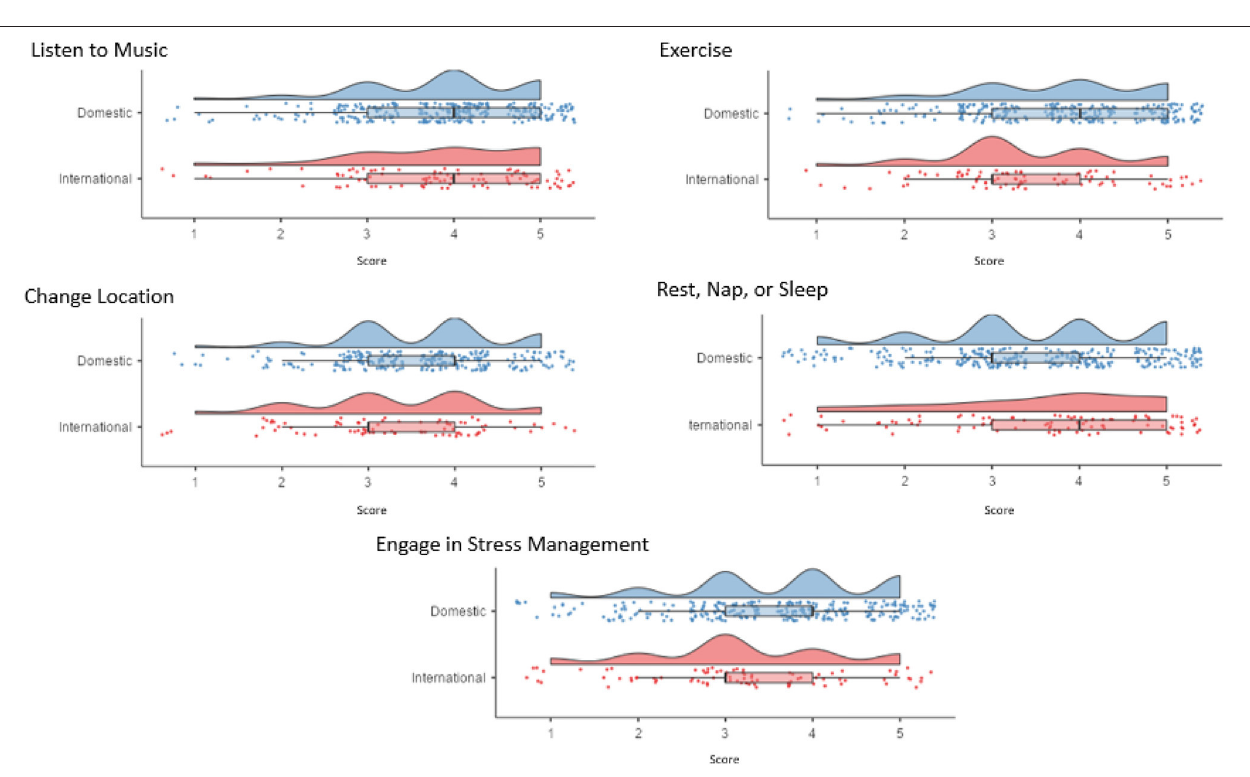
FIGURE 2 | Box and violin plots showing the distribution of effectiveness ratings, for domestic and international students, for the top five methods of